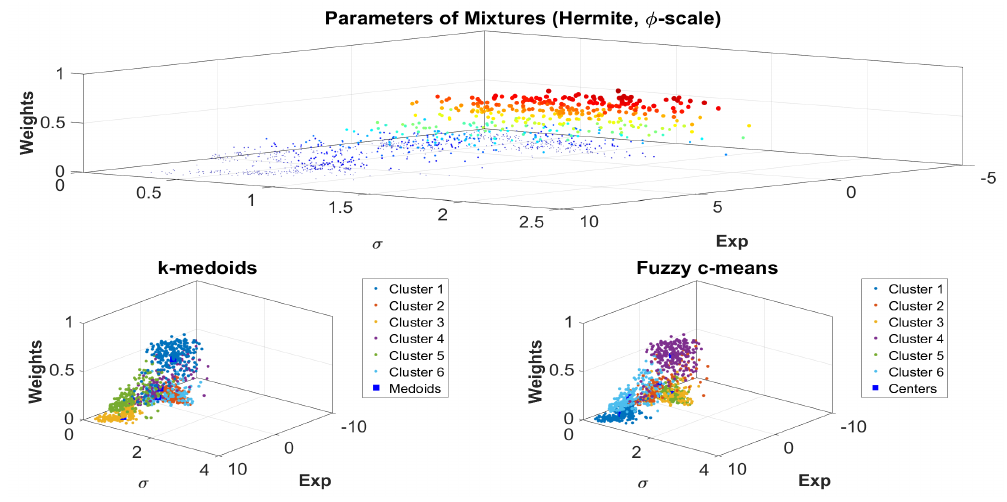
Figure A25. Clustering the mixture parameters (bootstrap, φ scale), 3D.